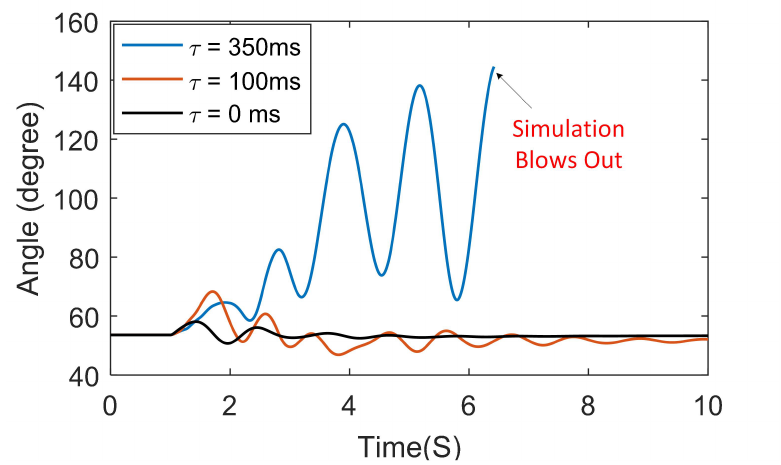
Figure 8. Machine 5–10 angle differences with different timing